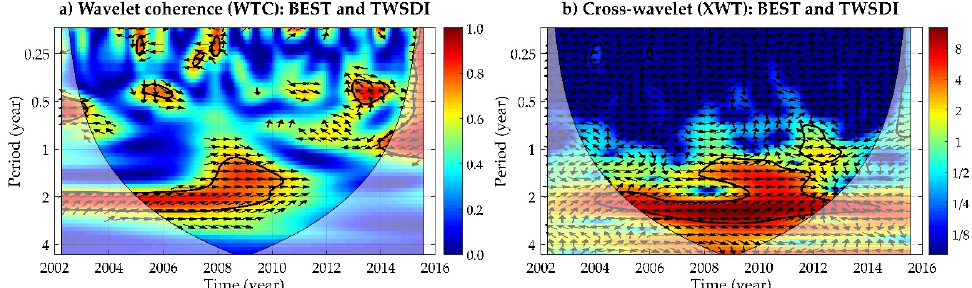
Figure 8. Wavelet coherency ( a ) and cross-wavelet power spectrum ( b ) analysis showing the relations between BEST and TWSDI. The thick black contour indicates the 95% confidence level against red noise and the cone of influence is shown as the lighter shade. The arrows (vectors) designate the phase difference between BEST and TWSDI with phase arrows pointing right ( → ): in-phase; pointing left ( ← ): anti-phase; pointing down ( ↓ ): BEST leading TWSDI by 90°; and pointing up ( ↑ ): TWSDI leading BEST by 90°.